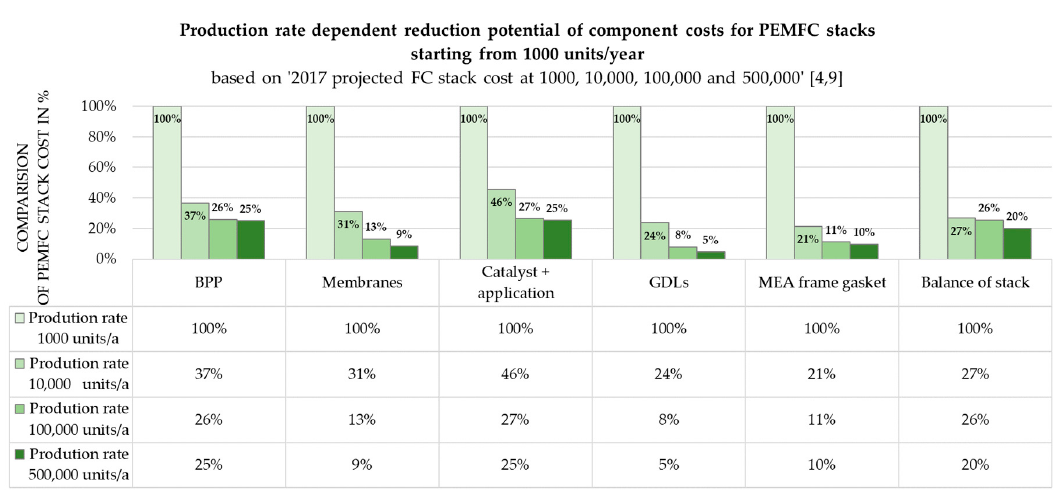
Figure 2. Production rate dependent reduction potential of component costs of PEMFC stacks starting from 1000 units/a based on [4,9].